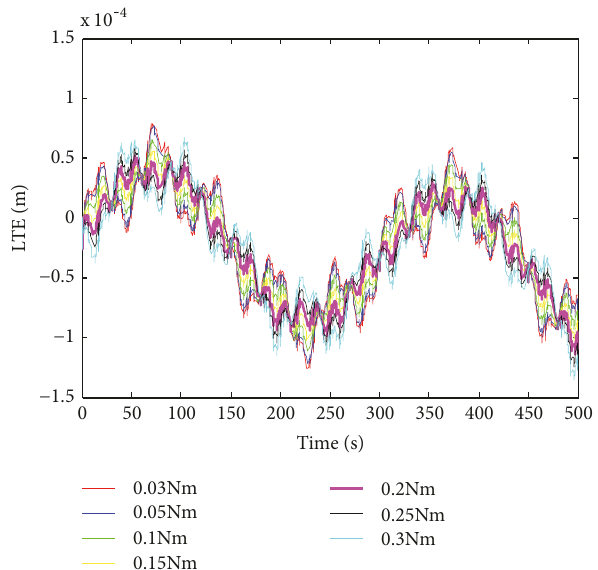
Figure 11: LTE curves under different amplitudes of sine load torque.